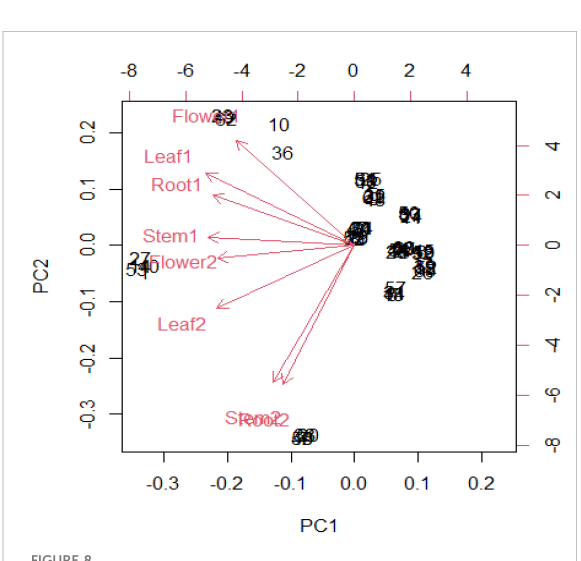
FIGURE 8 In R software biplot function has been used to plot PCA. The given biplot represents the fi rst principal component which combine ( fl ower, leaf) and little part of variation in (stem, root) in second principal